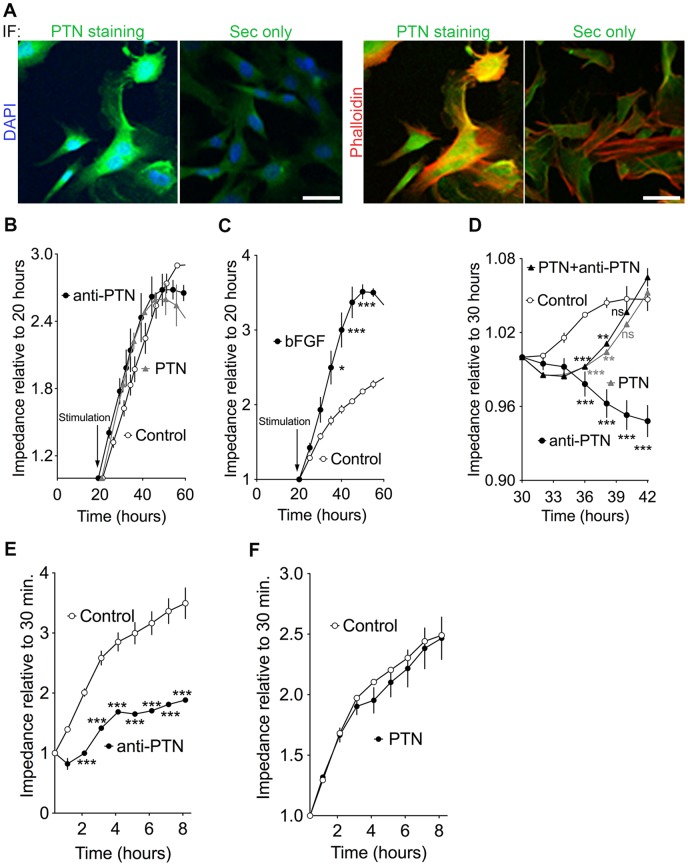
PTN protein expression and function in mammary epithelial cells (MECs).(A) Immunofluorescence (IF) staining of MECs grown on poly-D-lysine coated slides. PTN (green), DAPI (blue), Phalloidin (red). Images are shown as merged images of anti-PTN with DAPI and anti-PTN with Phalloidin staining. Scale Bar  = 20 μm. (B, C) Real-time impedance sensing of MECs growth relative to stimulation time (20 hours) with anti-PTN blocking antibody (anti-PTN), recombinant PTN (PTN), or antibody elution buffer (Control) (B), bFGF or resuspension buffer (C). (D) Real-time impedance sensing of MECs migration relative to 30 hours from plating and four hours from scratching. MECs were treated with anti-PTN blocking antibody (anti-PTN), recombinant PTN (PTN), alone or in combination or antibody elution buffer (Control). (E) Real-time impedance sensing of MECs invasion relative to 30 minutes from plating. MECs were treated with anti-PTN blocking antibody (anti-PTN), or antibody elution buffer (Control) (E), recombinant PTN (PTN) or PTN resuspension buffer (Control) (F). The data are representative of at least three independent experiments done in duplicates. ***P<0.001 versus control by ANOVA.